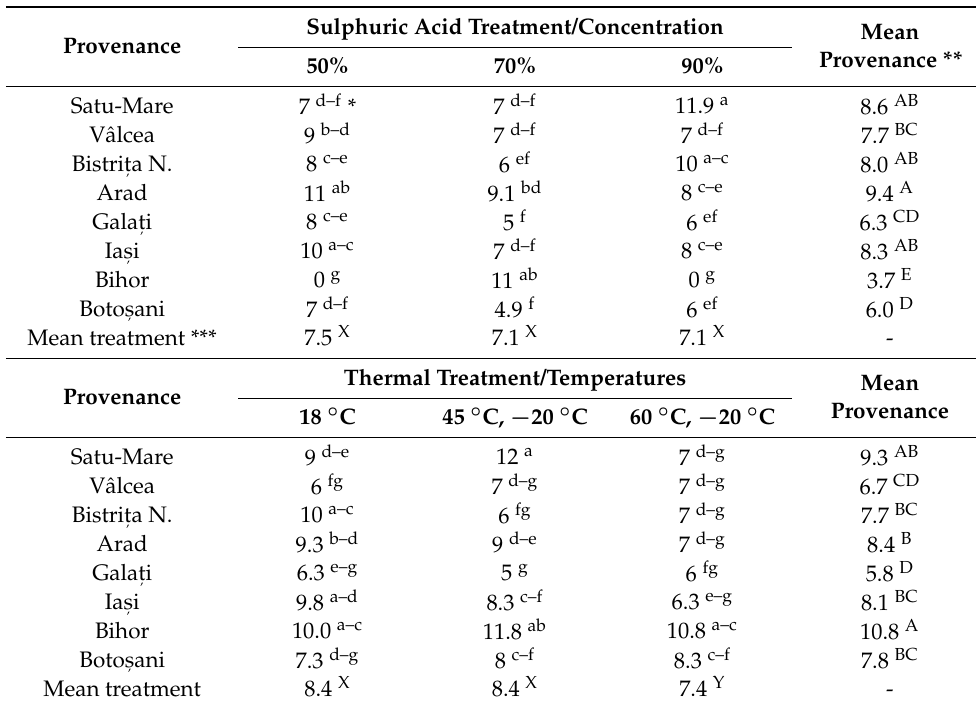
Table 6. Seedlings’ number of branches per stem depending on the treatments applied to black locust seeds.